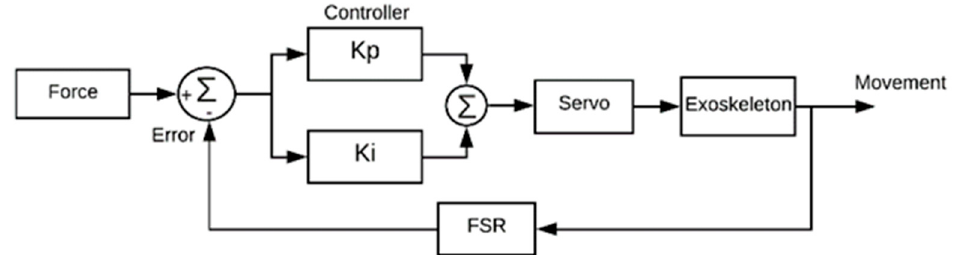
Figure 12. Feedback control diagram for the opening and closing of fingers.